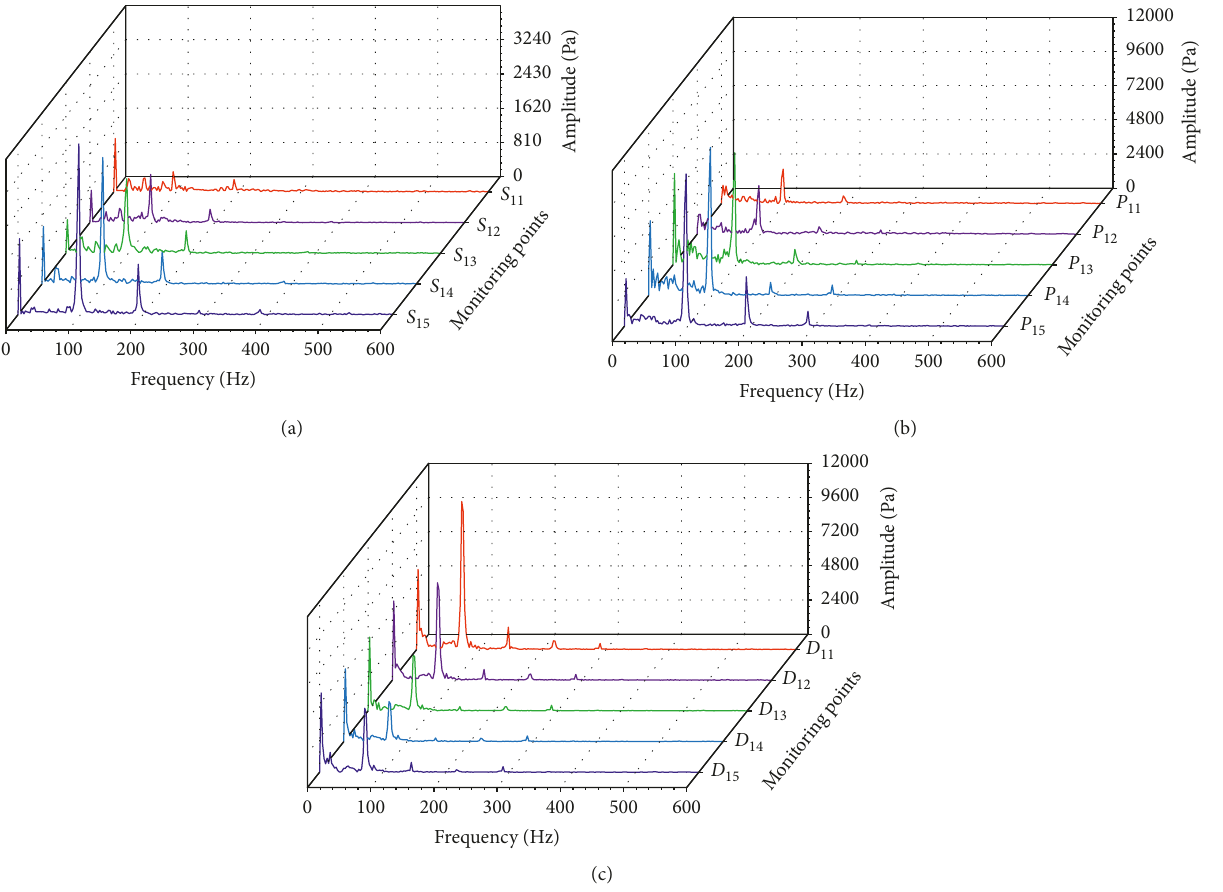
Figure 11: Pressure pulsation in the frequency domain at monitoring points during the first stage: (a) impeller blade suction side, (b) impeller blade pressure side, and (c)